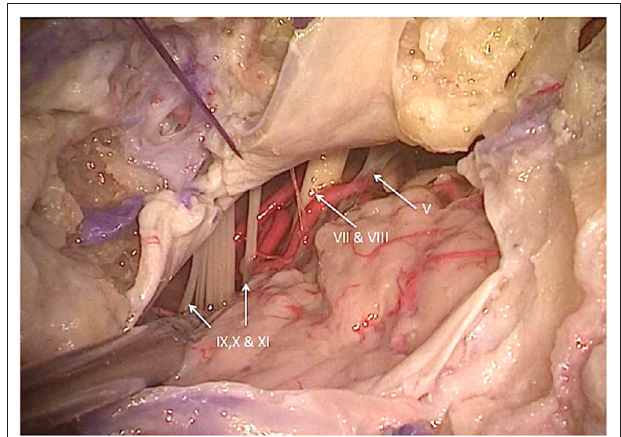
Frontiers in Surgery |